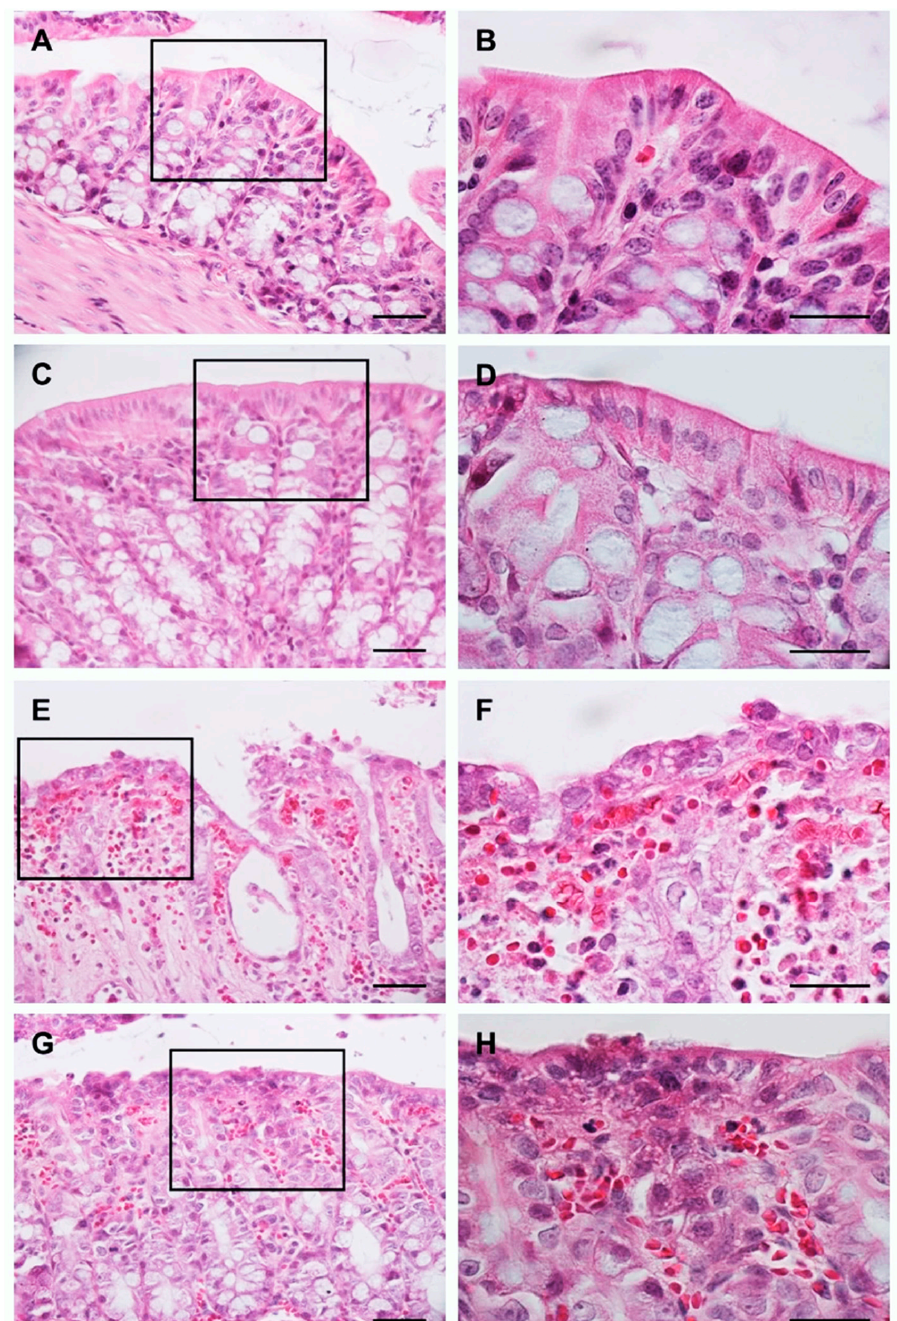
Figure 1. Evaluation of the morphology of the colon using the H&E stain. Images: ( A , C , E , G ) are at 40 × magnification, images: ( B , D , F , H ) represent 100 × magnification of the region marked with the rectangle in 40 × images. Scale bar: 100 µ m in all